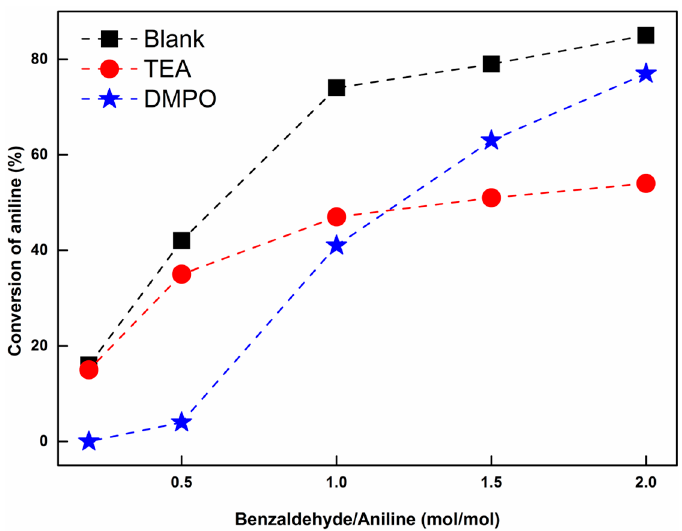
Figure 10. The conversions of nitrobenzene and benzyl alcohol, and the yield of imine by adding different additives.